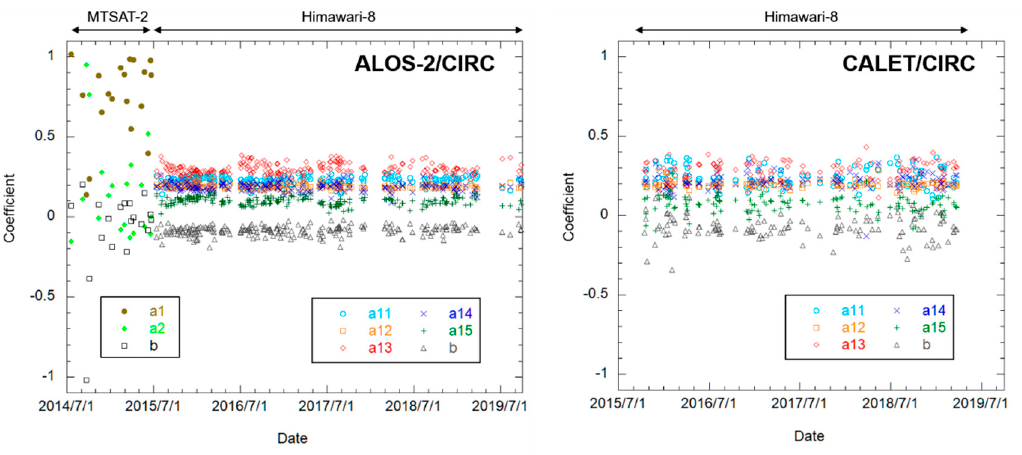
Figure12. Coe ffi cientsoftheAIRS-basedregressionequationsforALOS-2 / CIRC( left )andCALET / CIRC Figure 12. Coefficients of the AIRS-based regression equations for ALOS-2/CIRC (left) and ( right ) as a function of CALET/CIRC (right) as a function of date.